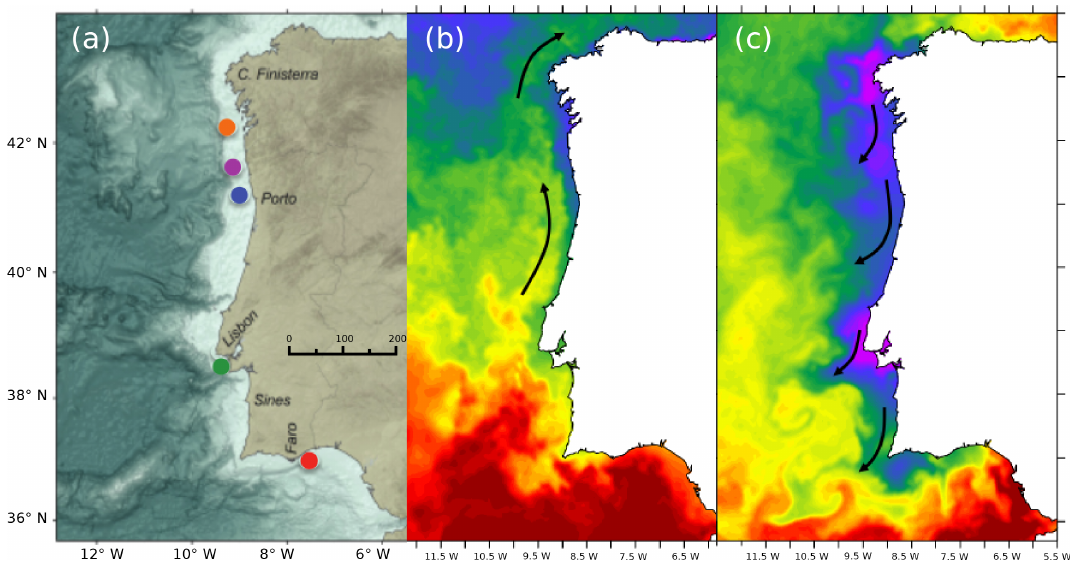
Figure 1. (a) : Core locations over Iberian Margin bathymetry: Geoß11033-1/Galiza in orange; DIVA09 GC/Minho in magenta; PO287-6B, -6G/Porto (Douro Mud Belt) in blue; PO287-26B, -26G, D130902, D13882 Tagus (Tagus Mud Belt) in green; POPEI VC2B/Algarve in red. The color assigned to each core location will be applied in all figures. (b) : Winter satellite-derived sea surface temperature (SST) image (23 January 2003) showing the surface signature of the Iberian Poleward Current. (c) : Summer SST image illustrating coastal upwelling conditions (colder coastal SST) along the western Iberian Margin (3 August 2005). Panels (b) and (c) : land covered areas appear in white; the color shades were selected to highlight the main oceanographic structures; the image source is JPL-PODAAC (https://mur.jpl.nasa.gov/).